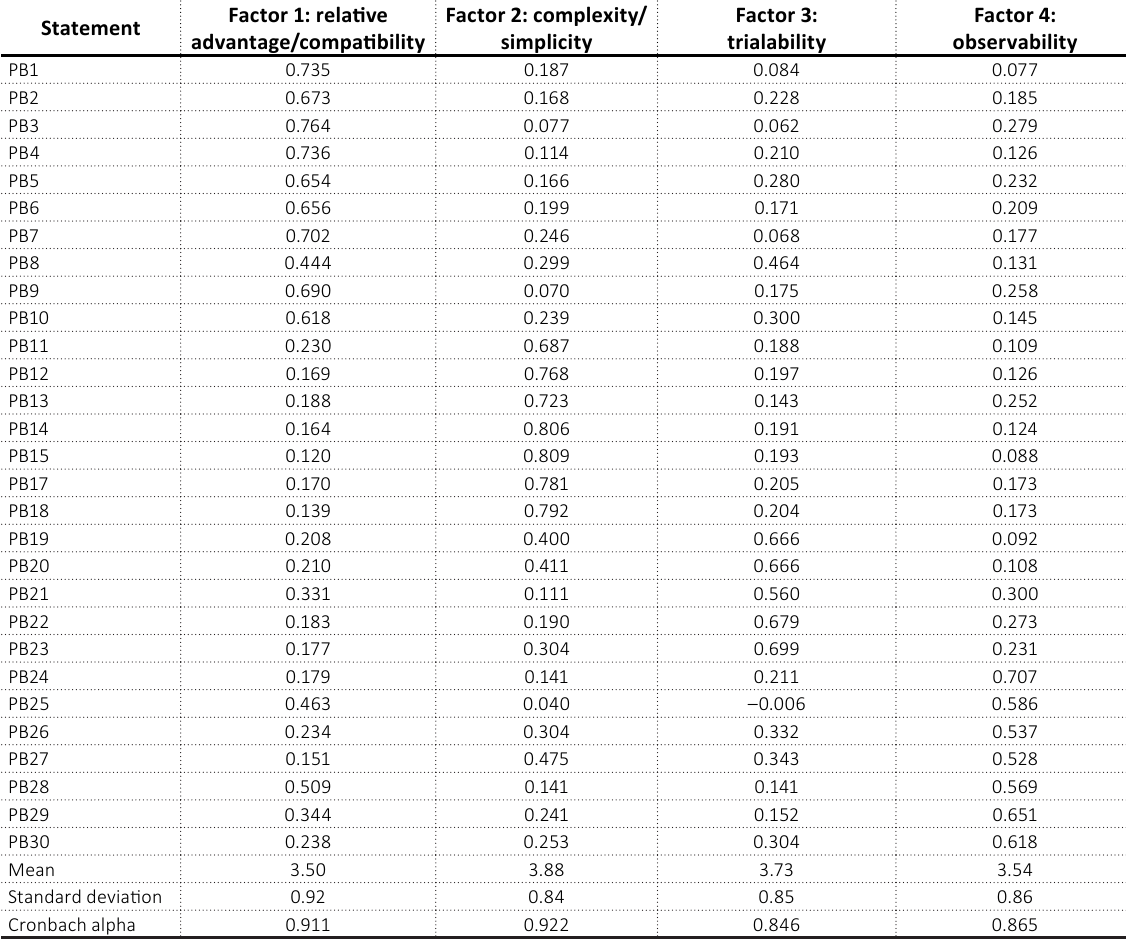
Table 5. Rotated component